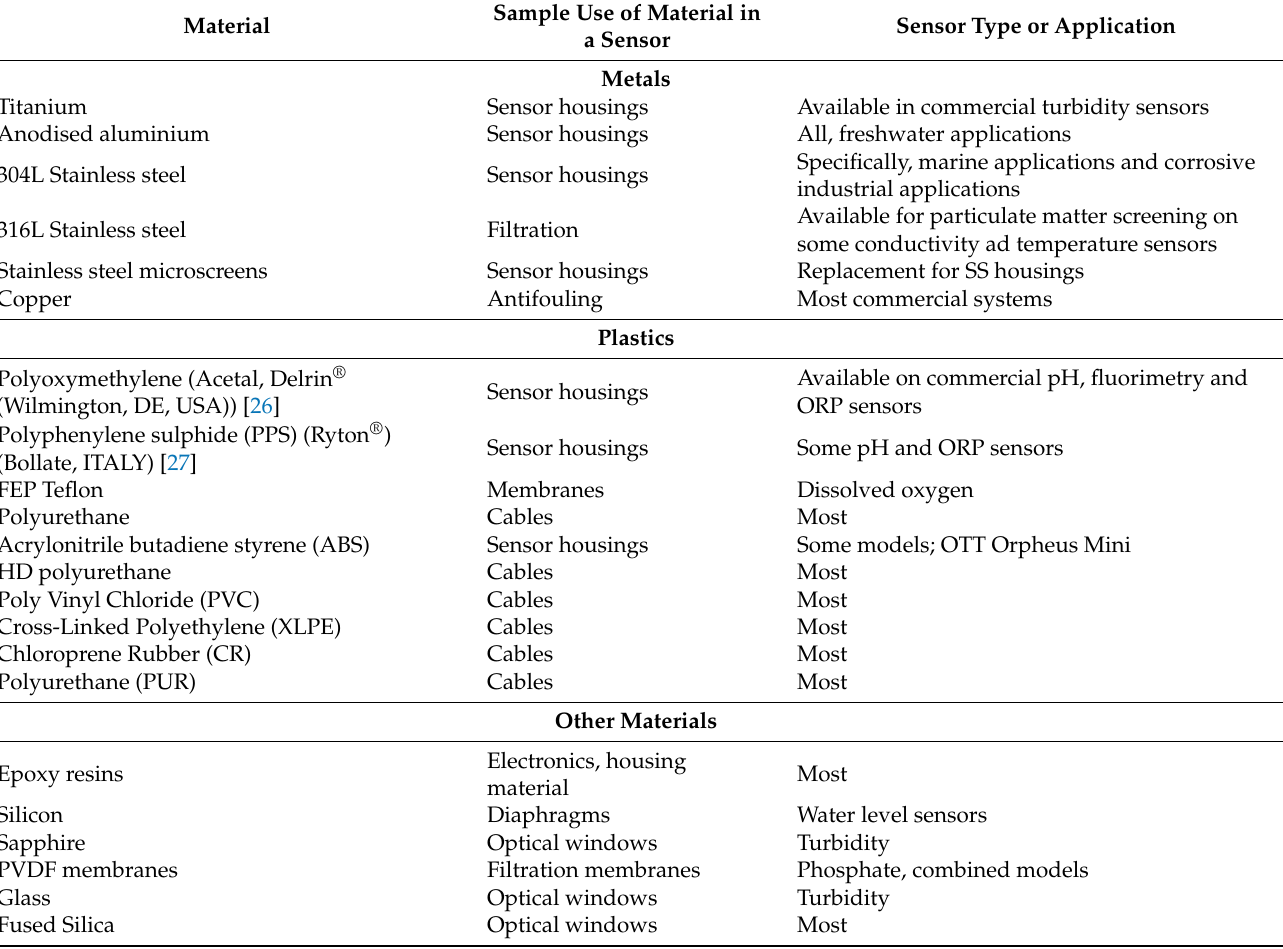
Table 1. Materials used in the sensor body, connections and sensor